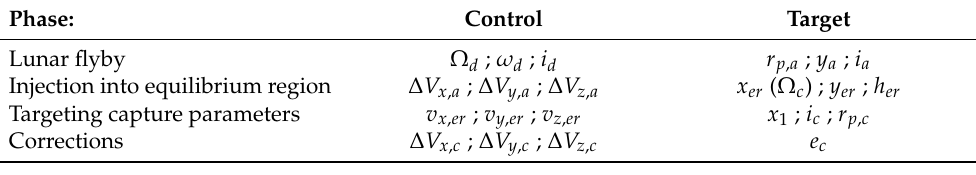
Algorithm 1 Deployment strategy